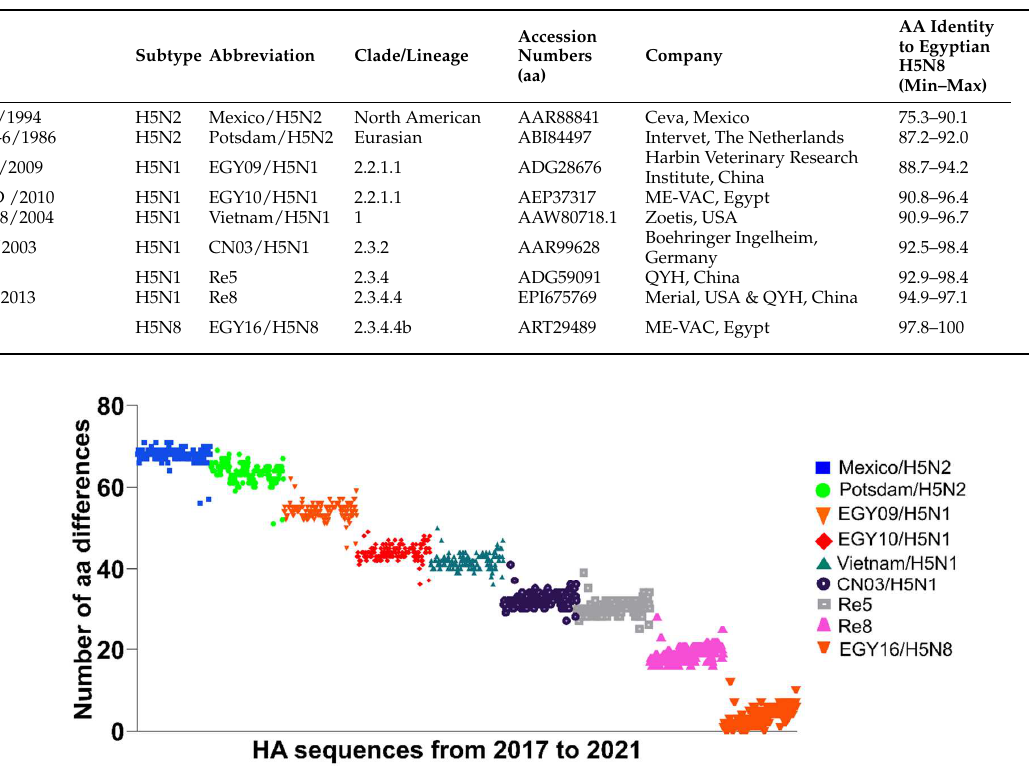
Figure 3. Amino acid differences of Egyptian H5N8 from 2017 to 2021 and licensed H5 vaccine strains in poultry in Egypt. Amino acid sequences of Egyptian H5N8 from 2017 to 2021 were retrieved from GISAID. All sequences including those generated in this study were aligned against different vaccine strains. Number of amino acid differences compared to the vaccine strain. Number of amino acid (aa) differences are shown in the y-axis. Each dot represents one HA sequence and sequences are arranged from 2017 to 2021. The figure was generated by GraphPad Prism 9.0.0 and was further edited using Inkscape 0.92. For the abbreviations of the vaccine strains, refer to Table 2. The Egyptian H5N8 viruses isolated in 2020/2021 possessed a higher number of aa Compared to the vaccine strain from the local Egyptian H5N8 strain differences compared to their ancestors in comparison to clade 2.3.4.4 vaccines, indicating a continuous genetic drift from the vaccine strains (Figure 4).